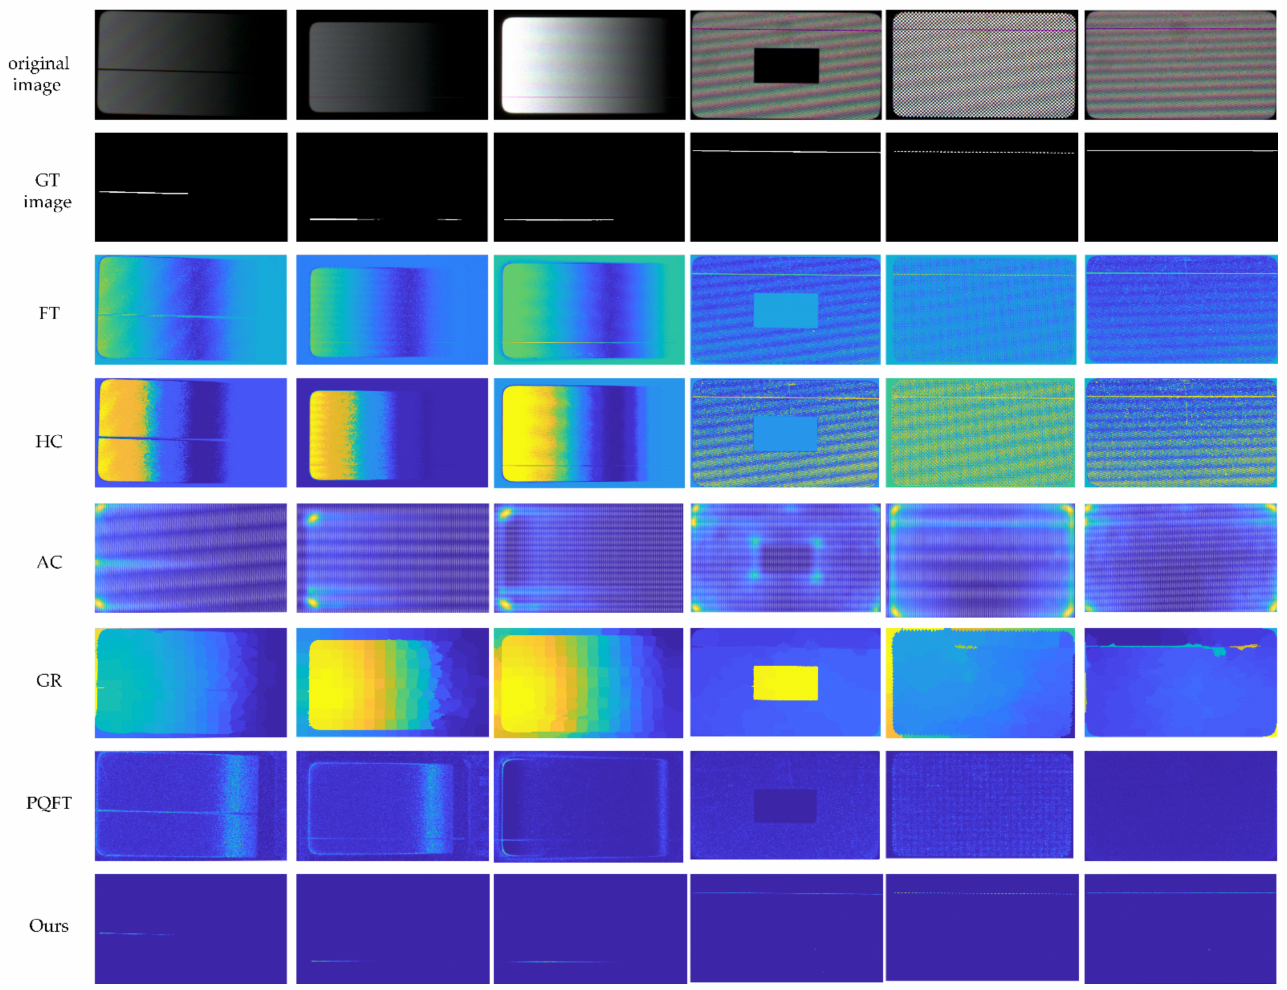
Figure 6. Comparison of saliency maps of different